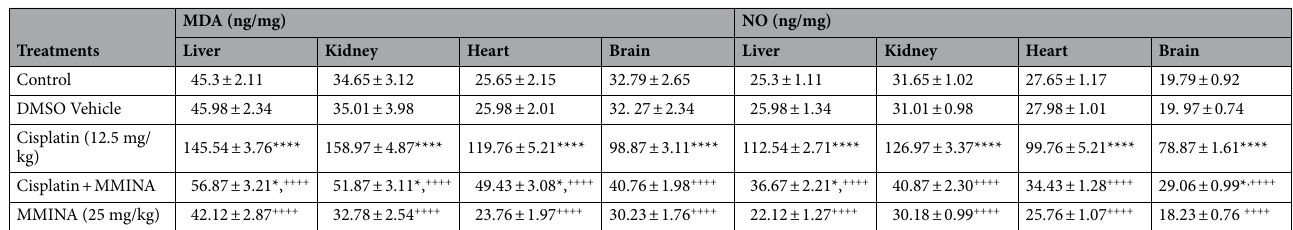
Table 1. Effect of treatment with MMINA on oxidative stress in cisplatin-treated rat organs. Data are mean ± SEM, (n = 6). *, **** p < 0.05 and p < 0.0001 versus Control respectively, and ++++ p < 0.0001 versus CP. Data analyzed by One-way ANOVA followed by Tukey’s multiple comparison